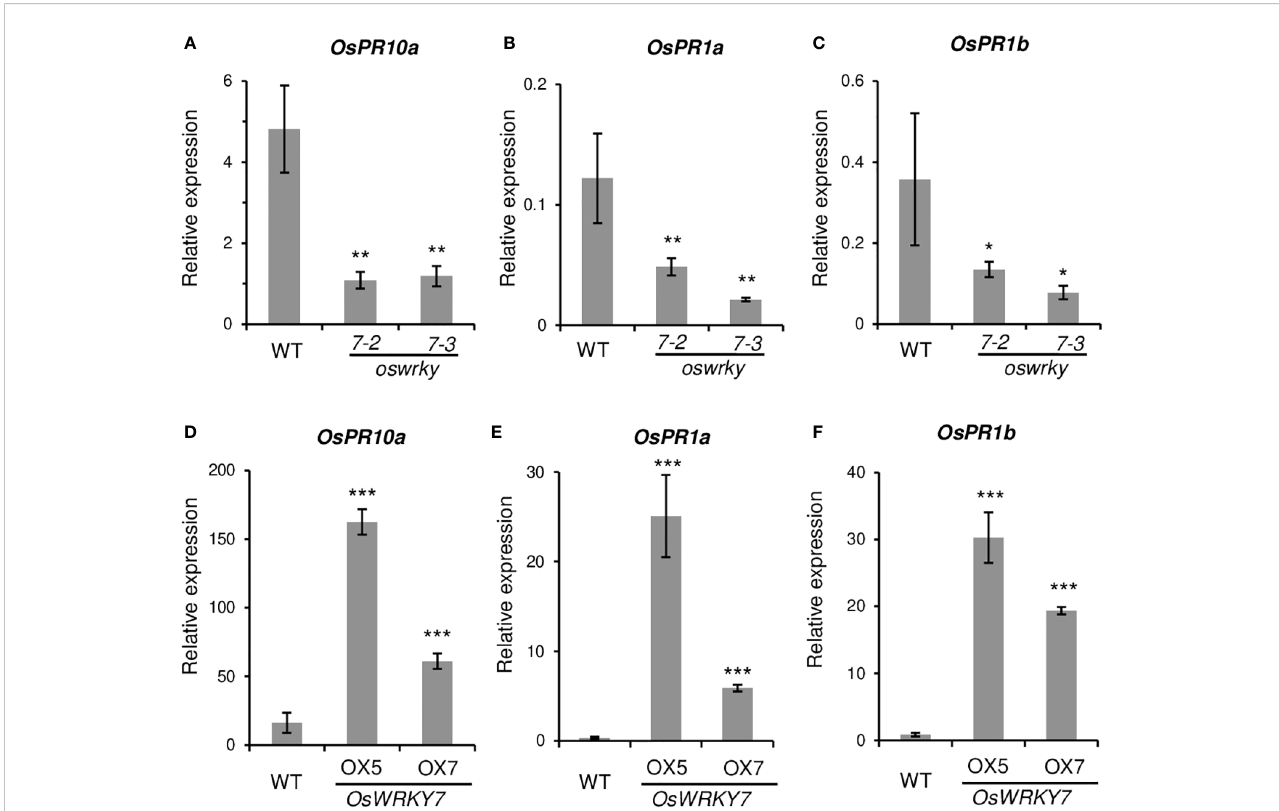
FIGURE 5 Expression levels of pathogen related genes in the WT and transgenic plants. (A-C) Relative transcript levels of OsPR10a (A) , OsPR1a (B) and OsPR1b (C) in the leaves of the WT and oswrky7 mutants. (D-F) Relative transcript levels of OsPR10a (D) , OsPR1a (E) and OsPR1b (F) in the leaves of the WT and OsWRKY7 overexpression plants. Samples were collected from the leaf blades at 42 DAG. The gene expression levels are relative to those of OsActin1 . Error bars indicate standard deviation; n = 3 or more. Statistical signi fi cance is indicated by *(P < 0.05), **(P < 0.01) and ***(P <